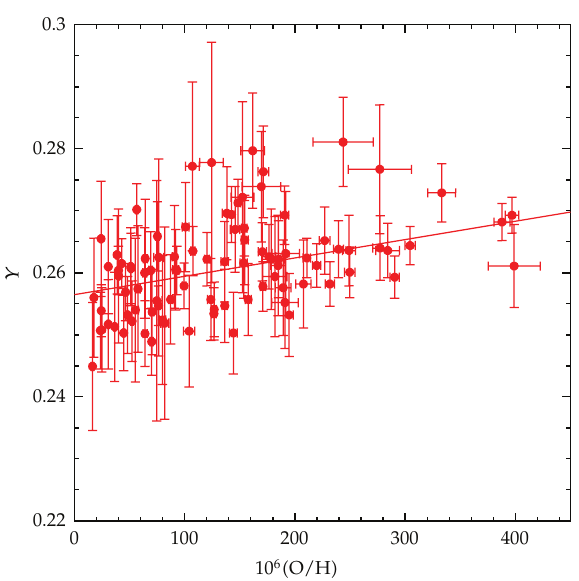
Figure 2: Helium abundance (cid:3) mass fractions, Y (cid:4) determinations from the sample of extragalactic HII regions studied by Izotov and Thuan (cid:3) 2010 (cid:4) (cid:5) 29 (cid:6) as a function of the corresponding oxygen abundances (cid:3) O/H by number (cid:4) . The solid line is the Izotov and Thuan best fit to a linear Y versus O/H correlation.